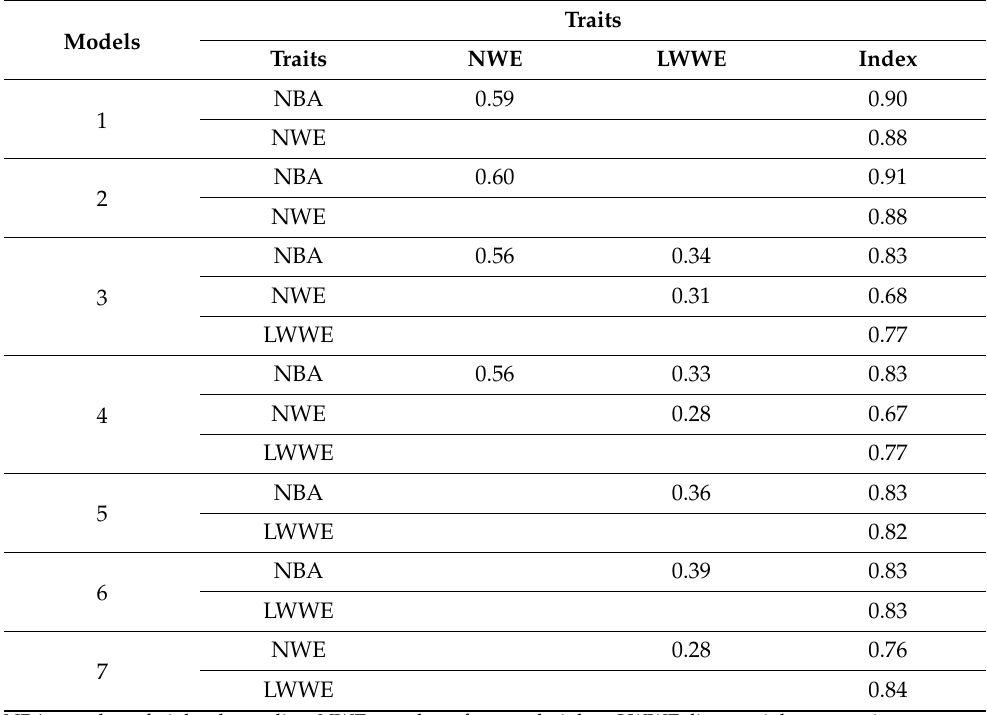
Table 11. Genetic correlation coefficient (Pearson’s correlation) between examined traits and the selection index score for the HLR (Pr > |t| <